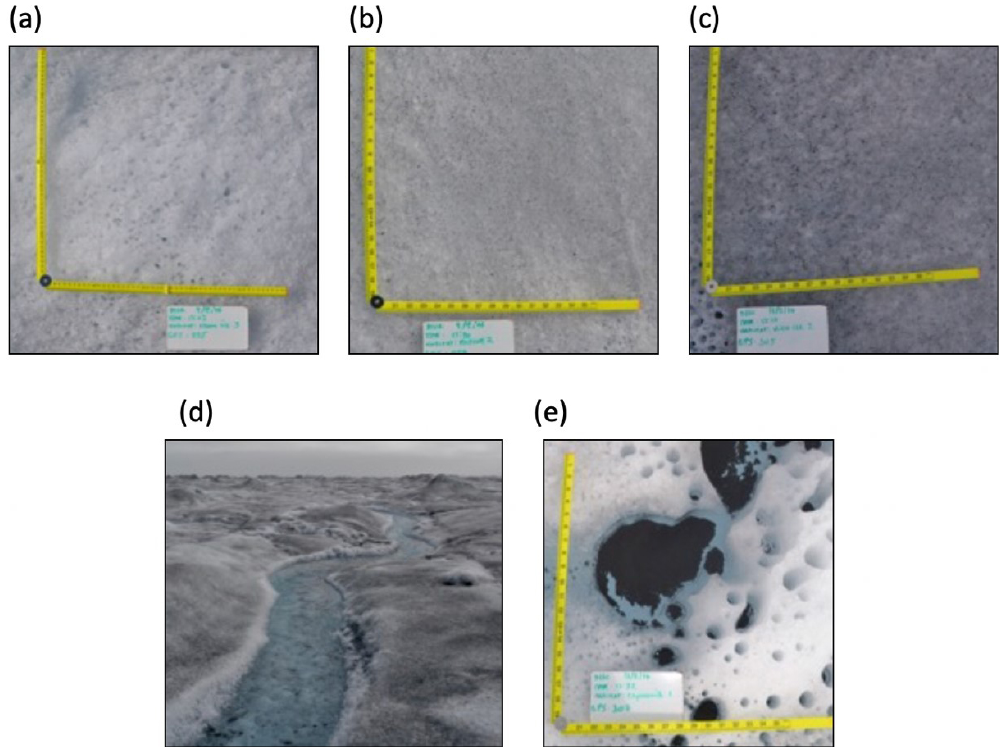
Figure 2. The five supraglacial habitats sampled: (a) ice with low visible impurities, (b) ice with medium visible impurities, (c) ice with high visible impurities, (d) supraglacial stream, and (e) cryoconite